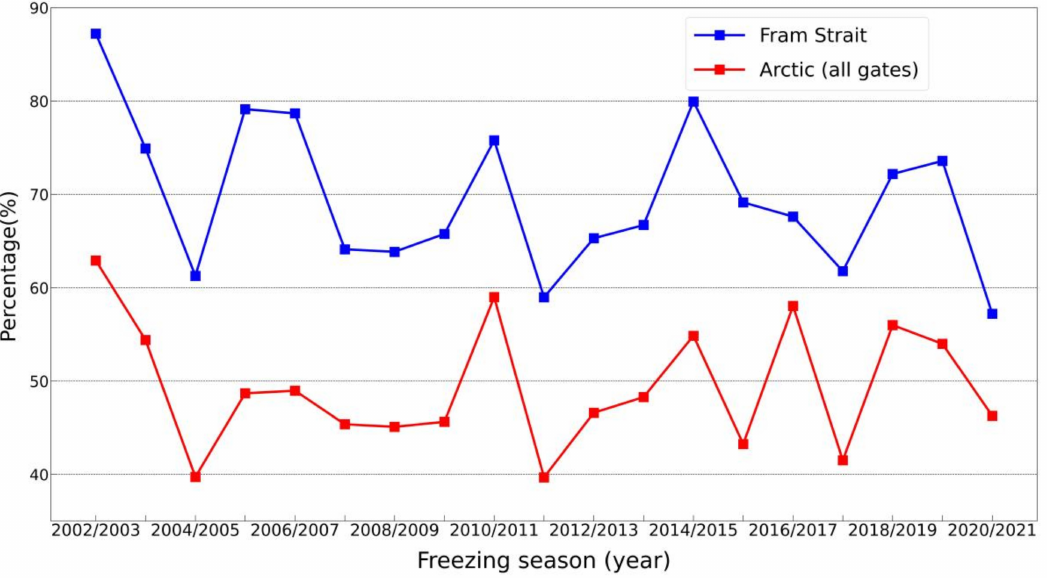
Figure 14. The ratio of winter MYI areal flux to the total sea ice areal flux through Fram strait and all the gates of